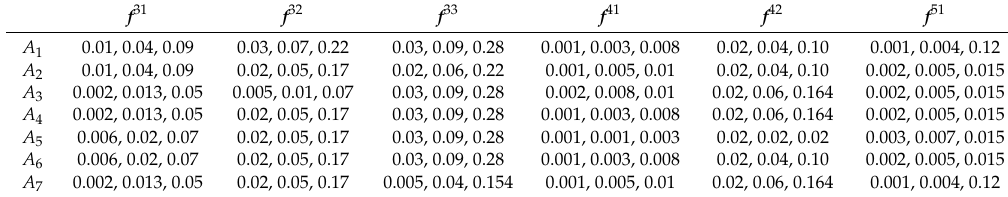
Table 10. Weighted normalized matrix for factor 3, 4 and 5